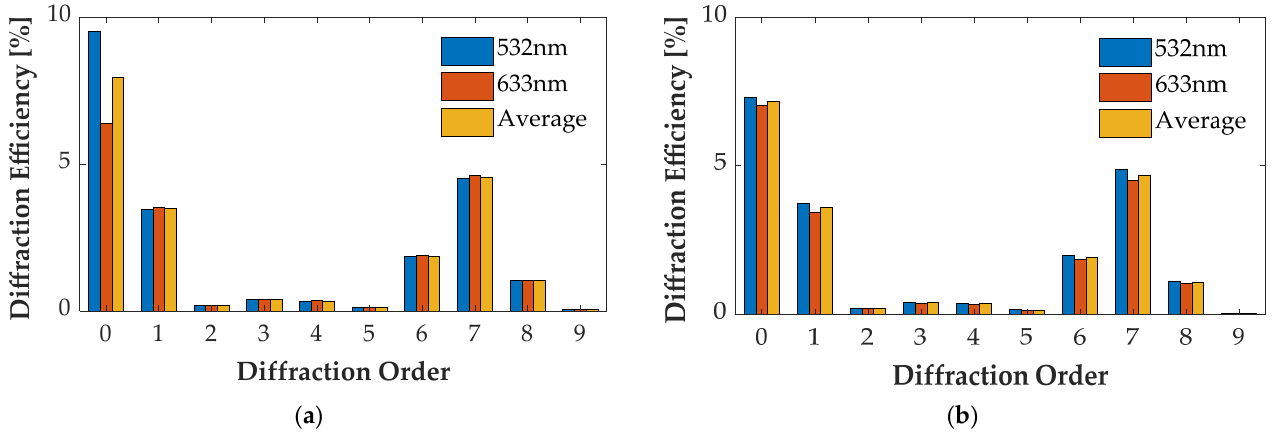
Figure 23. Diffraction efficiency of AH74. ( a ) AH74 with the groove depth of 158.25 nm; ( b ) AH74 with the groove depth of 143 nm.